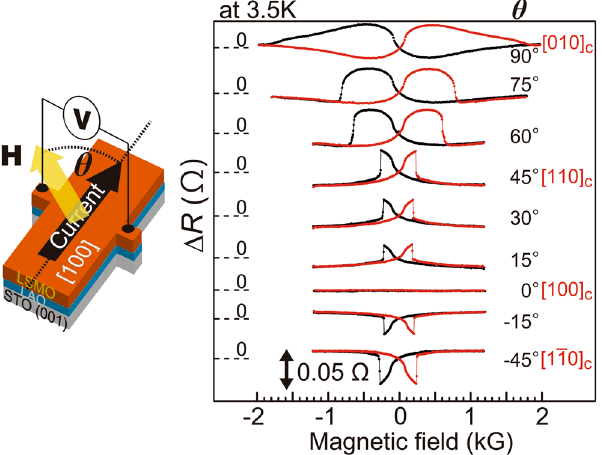
Figure 3. Magnetic anisotropy probed by planar Hall resistance. (Left panel) Schematic illustration of the Hall bar with a size of 50 × 200 μ m 2 formed along the [100] c direction using a reference sample of LSMO (40 u.c.)/ LAO (4 u.c.)/non-doped STO (001) substrate. (Right panel) Planar Hall resistance (PHR) Δ R of the reference sample with respect to the one at the zero magnetic field measured under various in-plane magnetic field H directions. The angle between H and the [100] c direction is denoted as θ